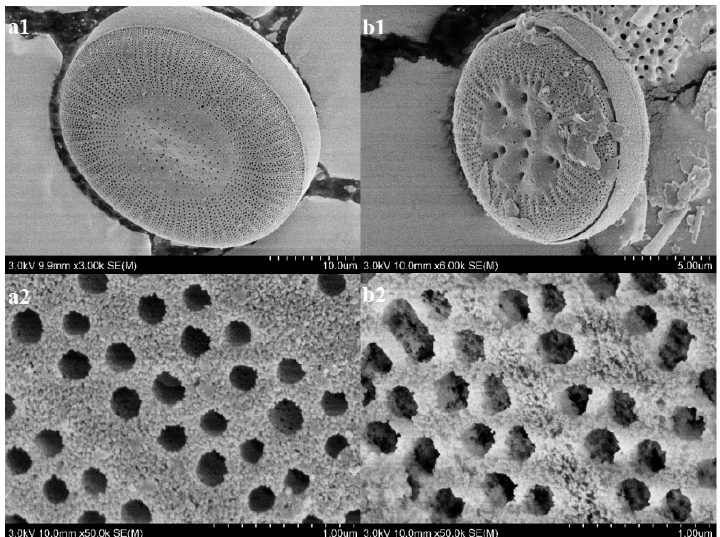
Figure 3. SEM images of raw Dt ( a1 , a2 ) and CS-modified Dt ( b1 , b2 ).